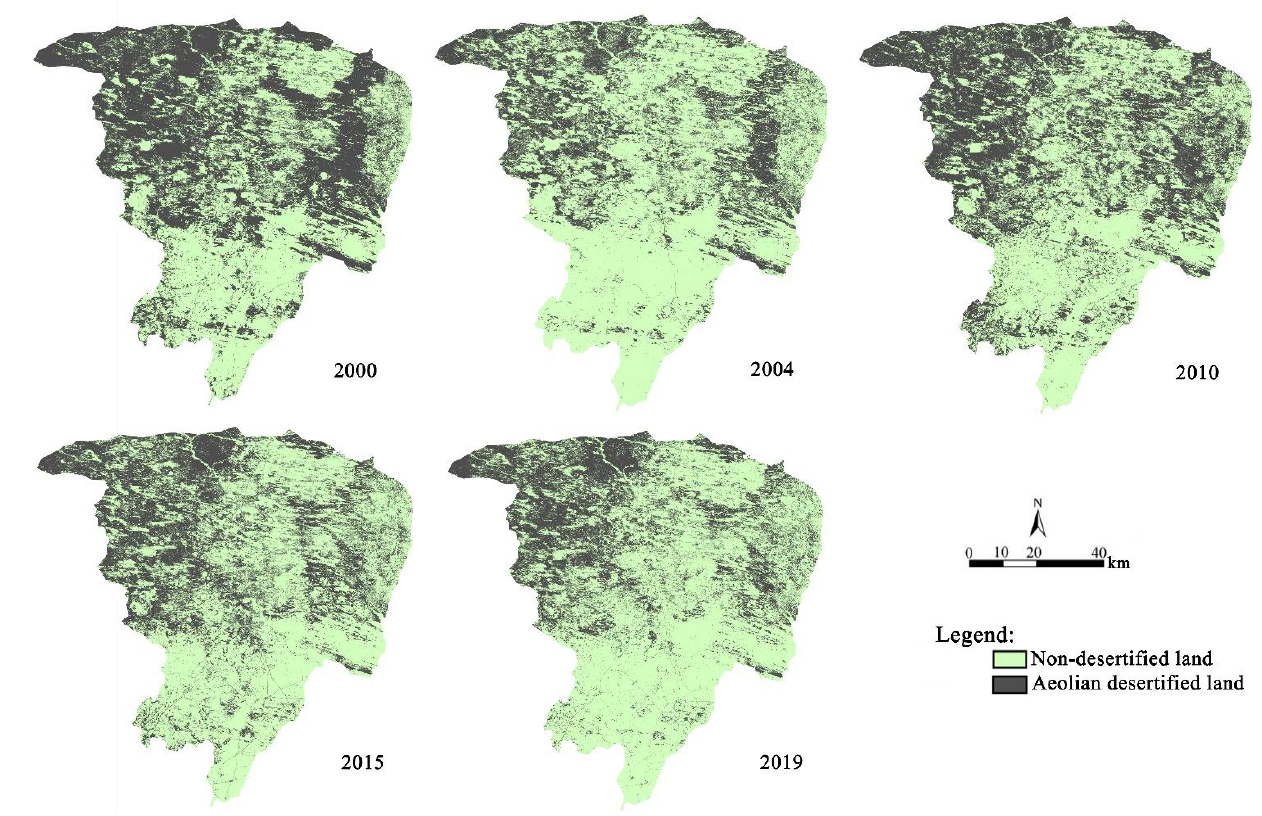
Figure 7. Extent of the ADL.